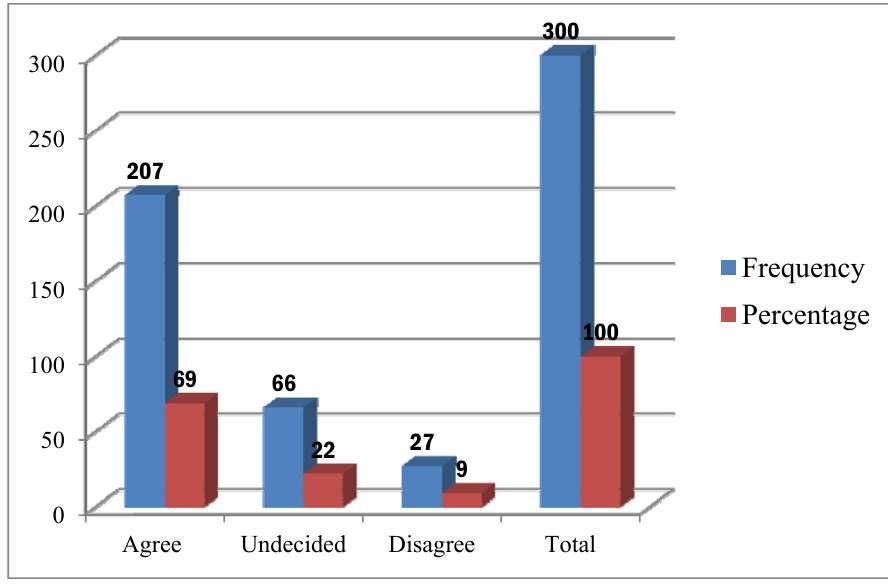
Bar Chart 6: Represent views of respondents on whether the nature of manpower planning and development curriculum in the Lagos state civil service is capable of producing an effective